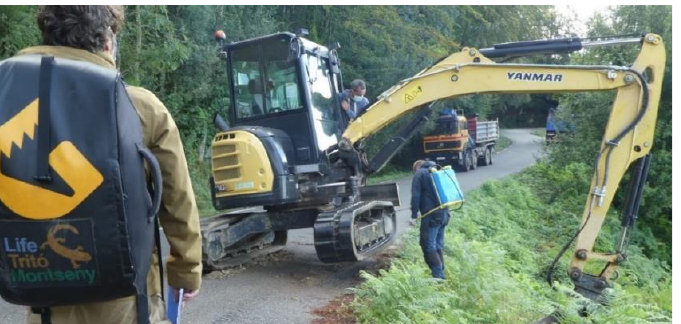
Figure 6. Biosecurity procedures to prevent the entry of pathogens in the C. arnoldi distribution area. The disinfection of all material and machinery with Virkon S is mandatory before and after all activities.